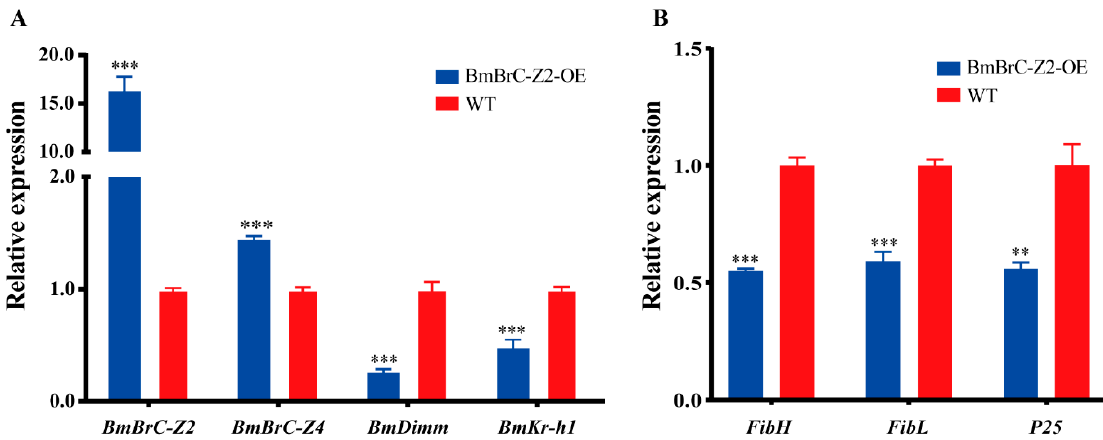
Figure 3. Relative expression levels of BmBrC-Z2 and related genes in the transgenic line. Including regulatory factors ( A ) BmBrC-Z2 , BmBrC-Z4 , BmDimm , BmKr-h1 and ( B ) fibroin genes FibH , FibL , P25 . RPL3 used as the control. **— p < 0.01, ***— p < 0.001); WT—wild-type; OE—overexpression.